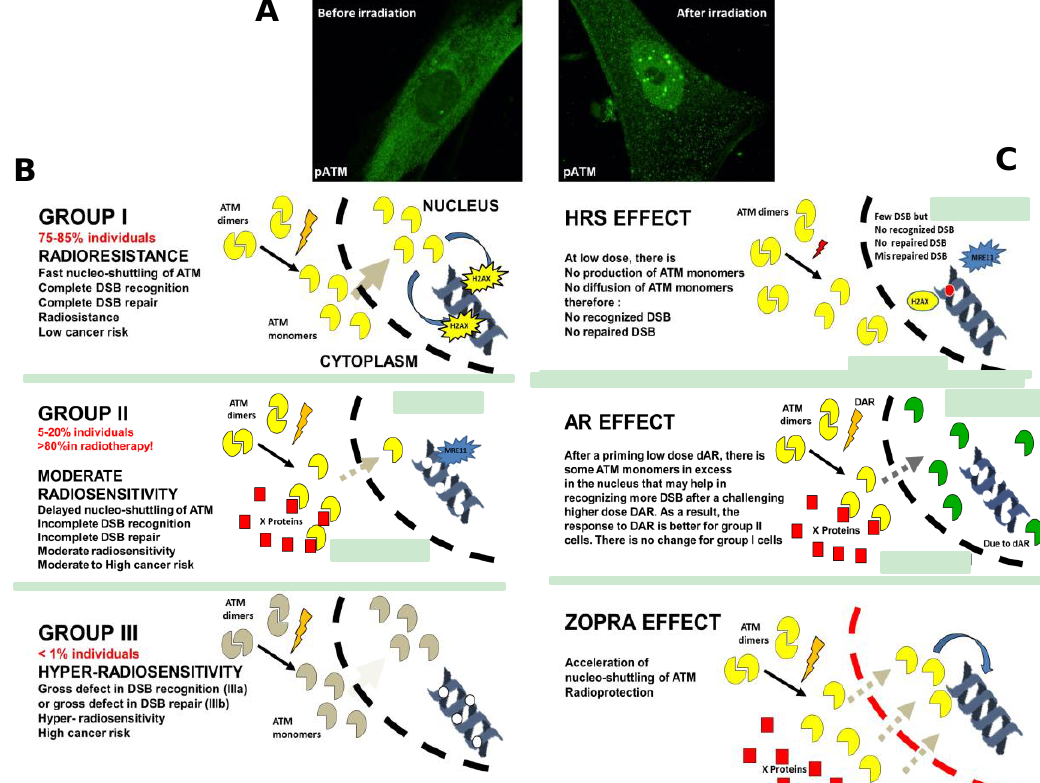
Figure 3. The radiation-induced ATM nucleoshuttling (RIANS) model and its applications. ( A ). Representative image of pATM immunofluorescence before or after irradiation (2 Gy) in human normosensitive control fibroblast cell lines. ( B ). Schematic illustration of the three groups of radiosensitivity defined from the RIANS model. ( C ). Schematic illustration of the hyperradiosensitivity to low doses (HRS) and the adaptive response (AR) phenomena and of the effect of the combination of statins and bisphosphonates (zoledronate+pravastatin, (ZOPRA)) on the RIANS. Since the link between radiosensitivity and the nuclear membrane permeability is still unknown, membranes are represented in the same manner.